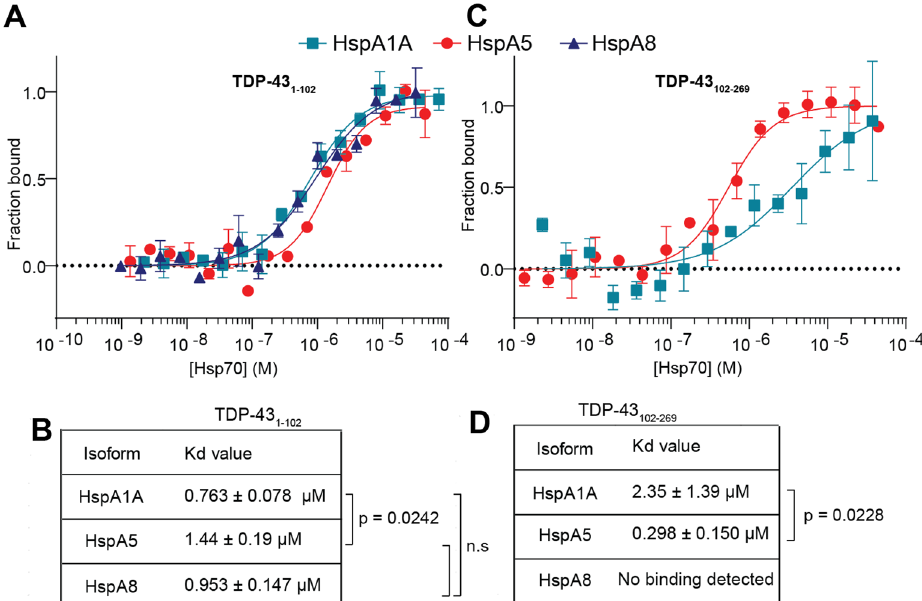
Figure 2. Selective binding of native TDP-43 constructs to Hsp70 isoforms. Microscale thermophoresis was used to measure the binding of ranging concentrations of Hsp70 SBDs to 50 nM of labelled TDP-43 1–102 ( A ) or TDP-43 102–269 ( C ). HspA1A and HspA5 were able to bind TDP-43 102–269 . No signal was detected for HspA8 binding to TDP-43 102–269 . ( B ) Table of affinity constants extracted from the MST values for TDP-43 1–102 . ( D ) Table of affinity constants extracted from the MST values for TDP-43 102–269 . Statistical difference was assessed between HspA1A and HspA5 binding (Welch’s test). Data is presented as Mean ± SD (n = 3). Statistical difference was assessed between HspA1A, HspA5 and HspA8 binding (Brown-Forsythe and Welch ANOVA